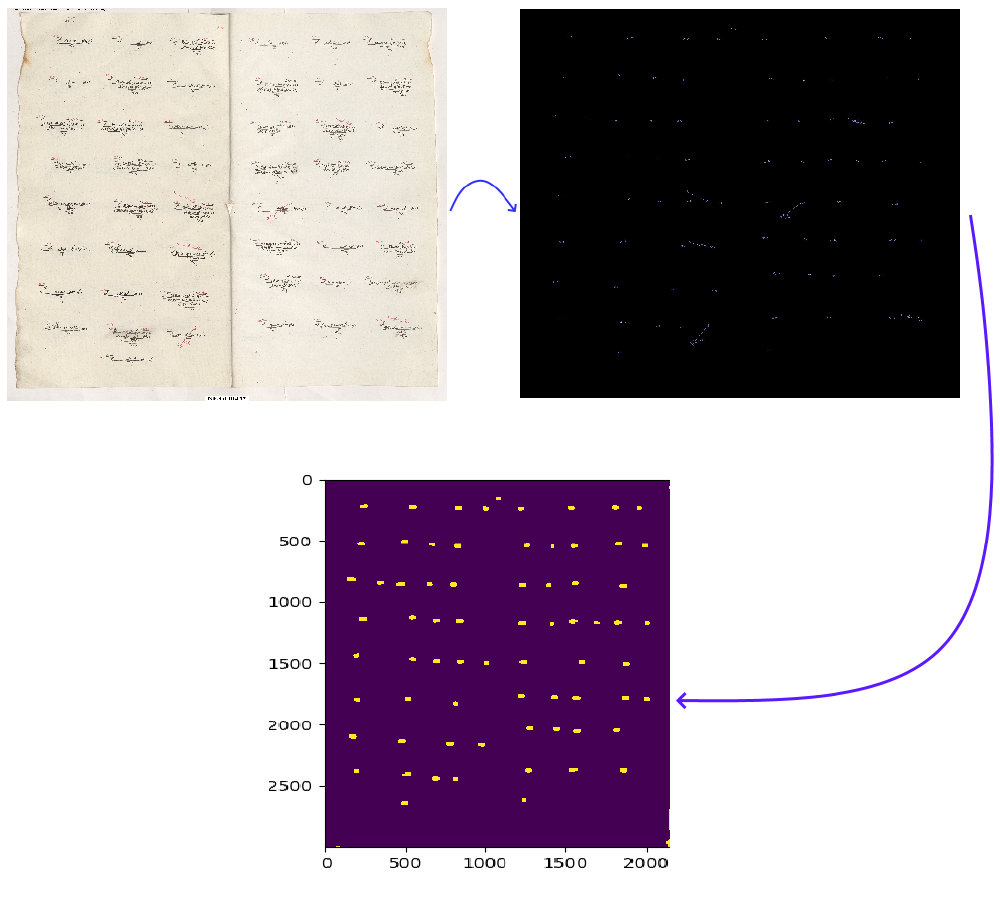
Figure 6. The complete processing of numeral spotting is shown. First, a red mask is applied to the original image. The masked image is shown in the middle. Lastly, a binary prediction image for spotting numerals is